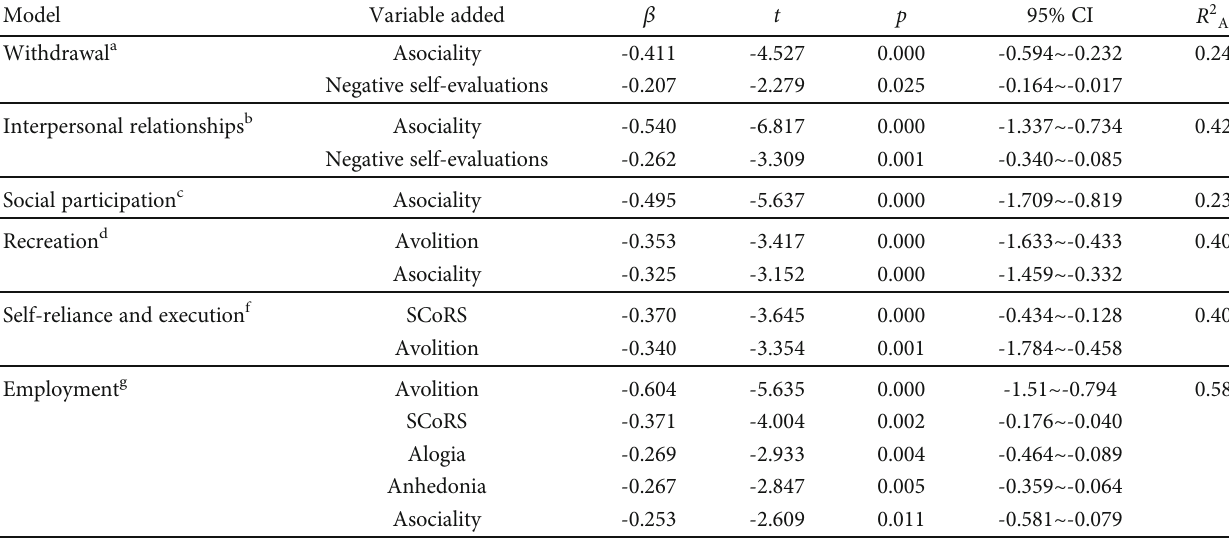
Table 3: Hierarchical multiple regression analysis with di ff erent facets of functioning as the dependent variable ( fi nal